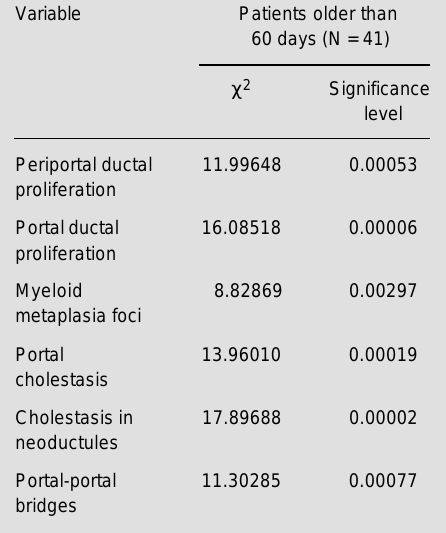
Table 2 - Discriminant hepatic histopathological variables between IHC and EHC in relation to pa- tient age. No variable discriminated between IHC and EHC in patients younger than 60 days. Chi-square with Yates